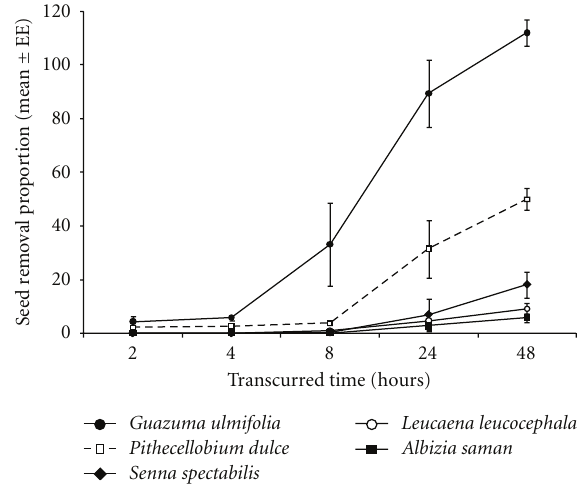
Figure 2: Removal of seeds by ants overtime. Average number of seeds removed from depots 2, 4, 8, 24, and 48 hours, after initiating o ff er, are showed ( n =